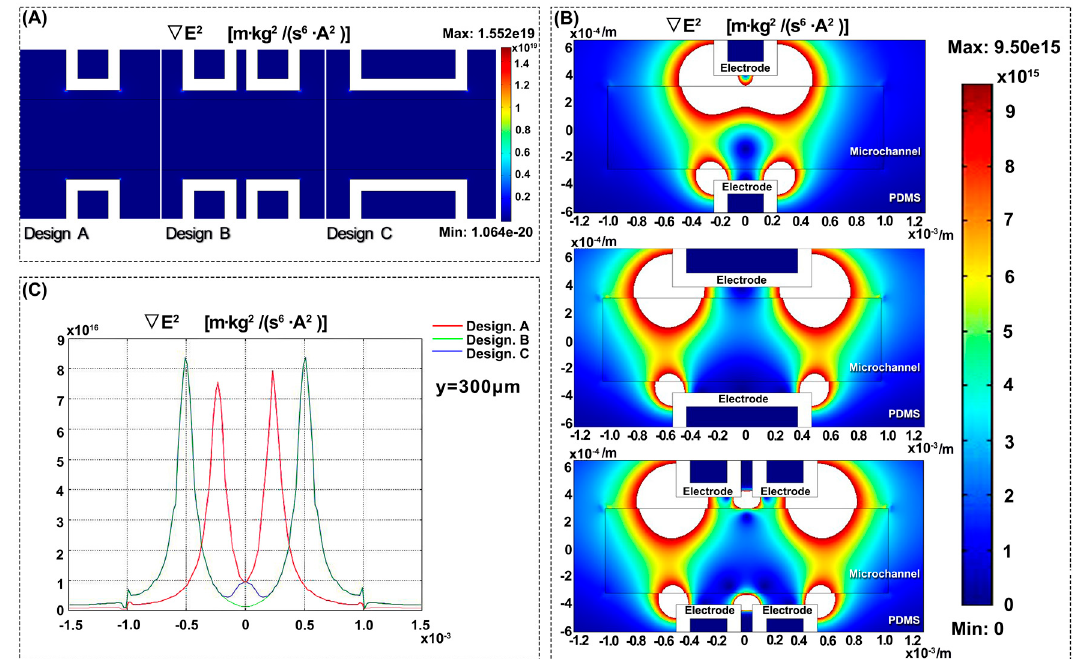
Figure 7. Numerical simulation of ∇ E 2 for an electric potential of 1500 V applied to the upper electrodes of three designs. ( A ) Full value of ∇ E 2 in three designs; ( B ) Limiting value of ∇ E 2 ranging from 0 to 9.50 × 10 15 ; ( C ) Value of ∇ E 2 on the sidewall near the charging electrodes.